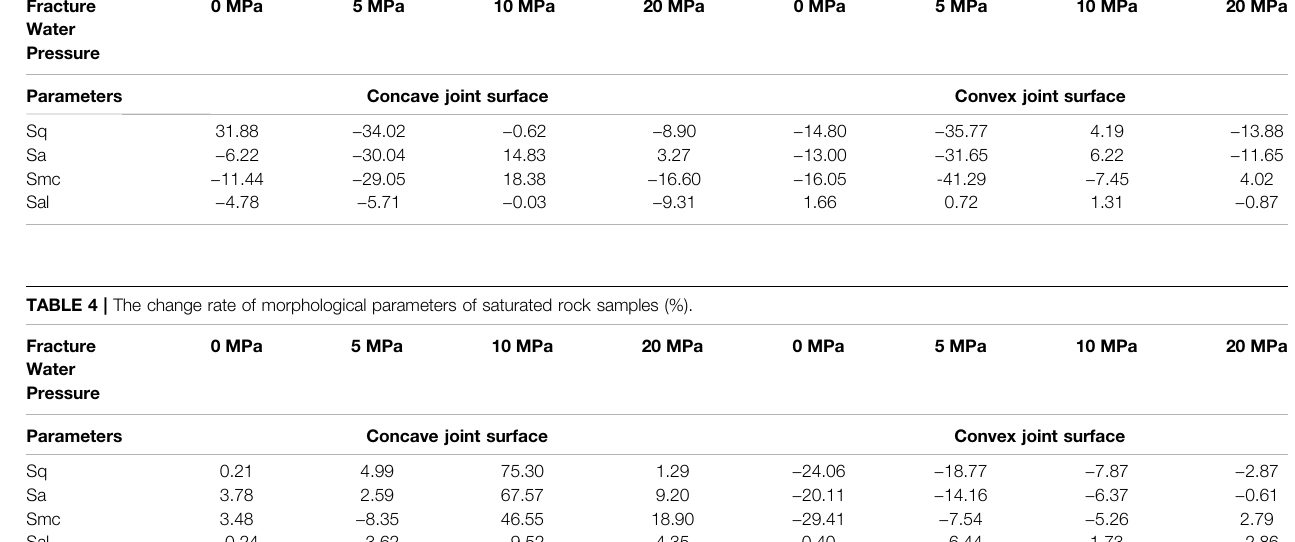
TABLE 3 | The change rate of morphological parameters of dry rock samples (%). Fracture Water